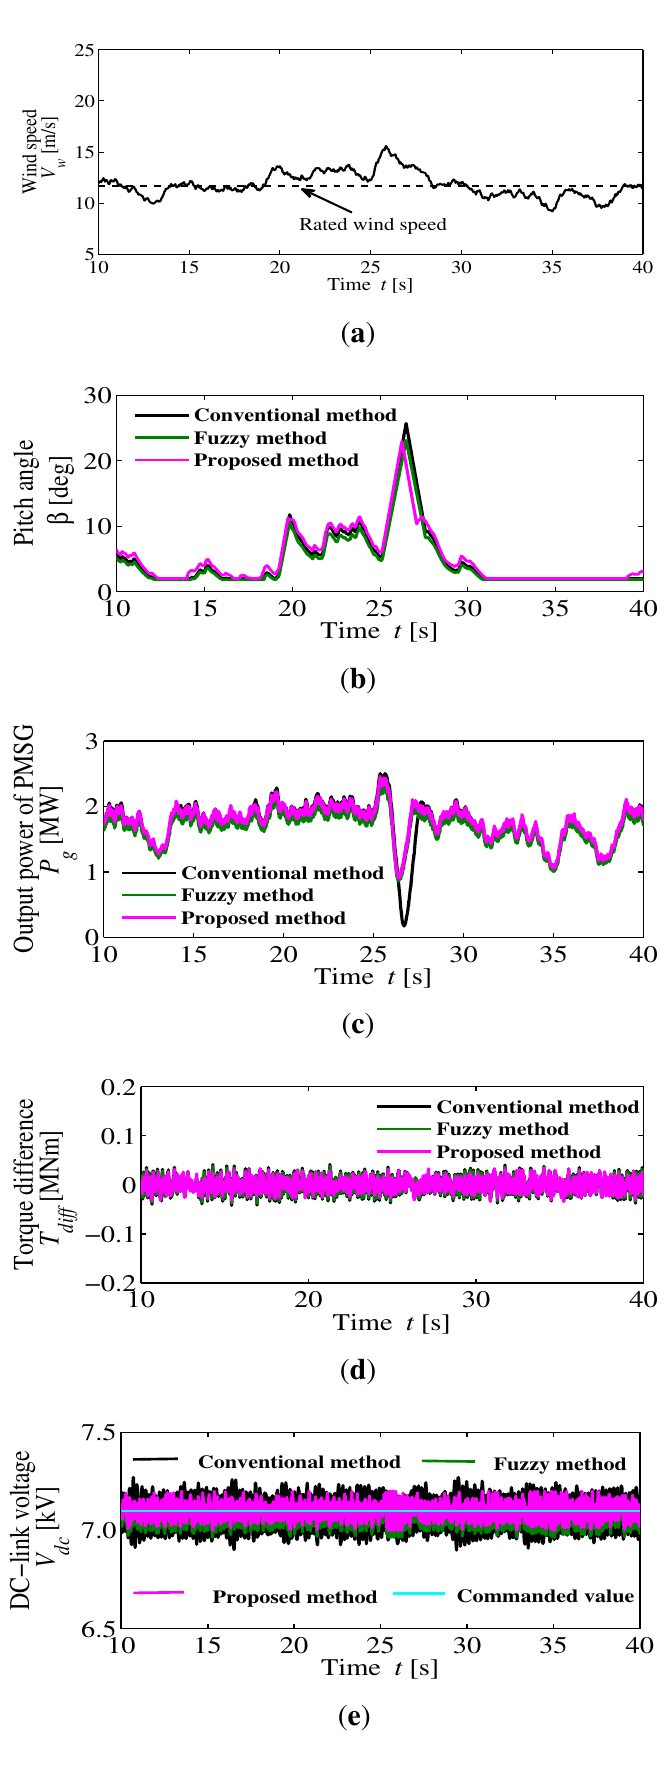
Figure 14. Simulation Results (Low turbulence wind speed). ( a ) Wind speed; ( b ) Pitch angle; ( c ) Output power of PMSG; ( d ) Torque difference; ( e ) DC-link voltage; ( f ) DC-link current; ( g ) Output power of grid-side